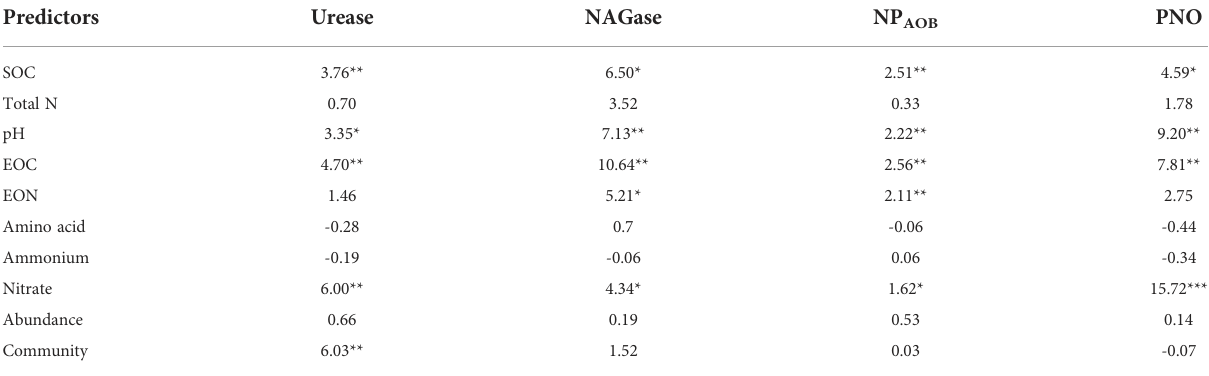
TABLE 2 Random forest mean predictor importance (percentage of increase of mean square error) of soil chemical properties and the abundance and community of N-cycling functional groups as drivers of their corresponding N process rates. Predictors